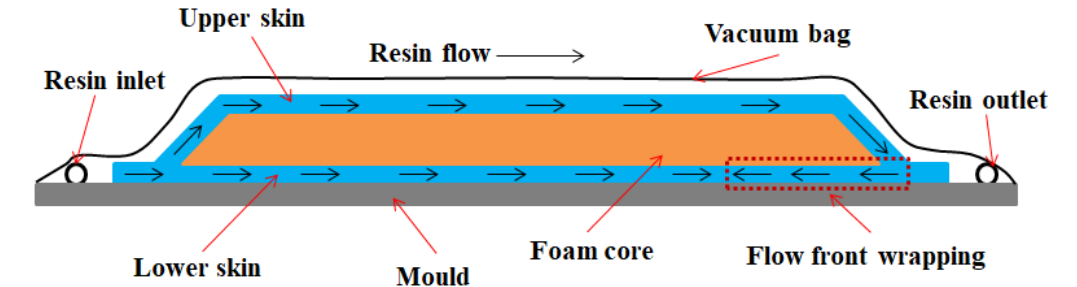
Figure 7. The reverse flow of resin in the lower skin under the 4/4 RDM area.